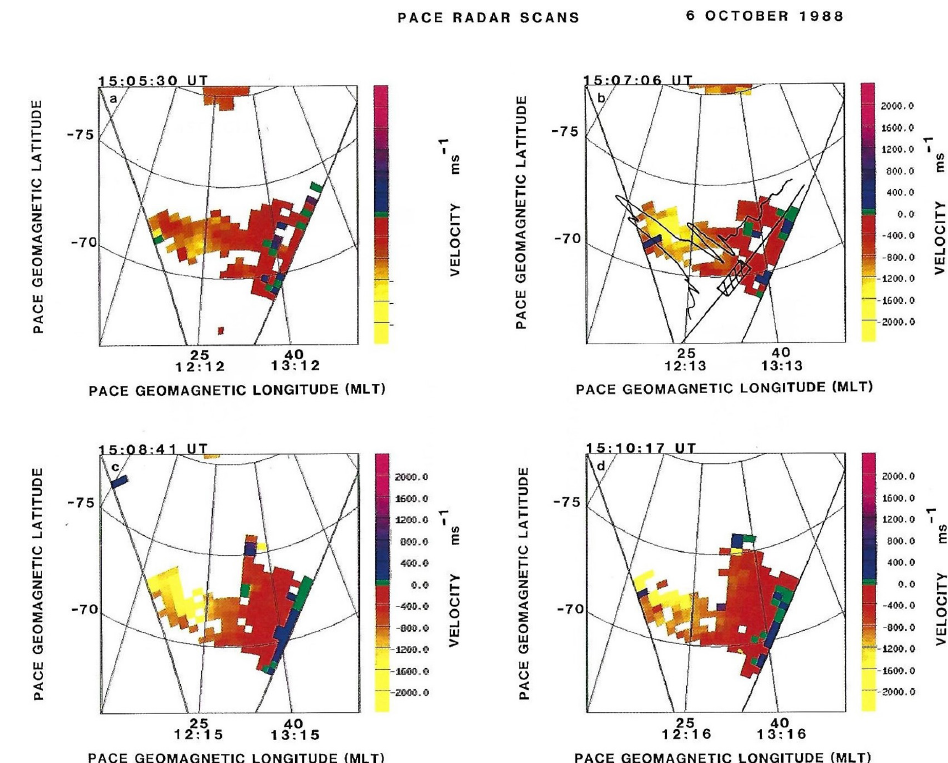
Figure 11. On 6 October 1988, the Halley radar detected six enhanced flow channels in the cusp ionosphere. Of these, one occurred at 15:07–15:08UTC in association with a passage of the DMSP F7 spacecraft through the Halley radar field of view (see b ). The hatched region along the trajectory identified the location of the cusp, and the curved line indicates the drift velocity of the plasma toward the northwest. Reproduced from plate 2 of Pinnock et al.